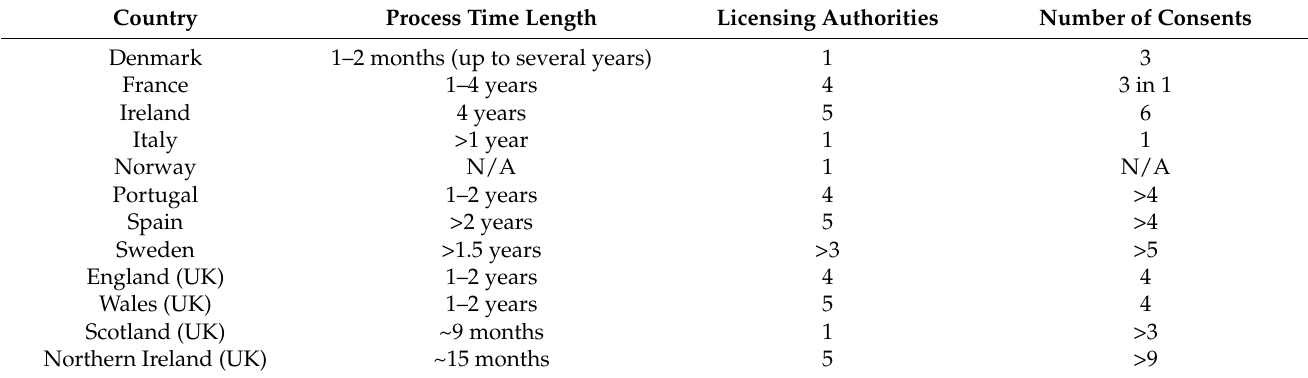
Table 2. Summary of the main aspects of the consenting process for ocean energy. Adapted from [34]. Country Process Time Length Licensing